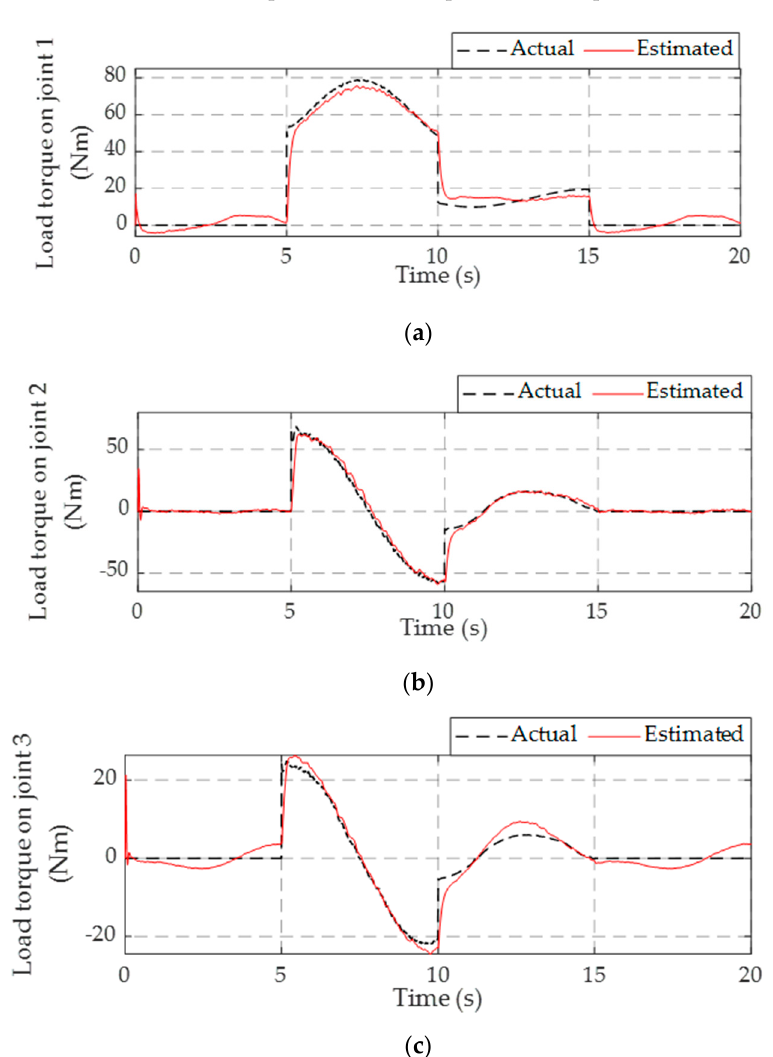
Figure 19. The load torque estimated of the: ( a ) first joint, ( b ) second joint, and ( c ) third joint.